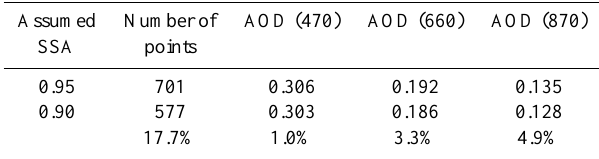
Table C1. The number of points with the RR-derived AODs (leg 10) and the corresponding mean values of AOD at three wave- lengths (470, 660 and 870nm) obtained for two cases with different assumptions about aerosol SSA.